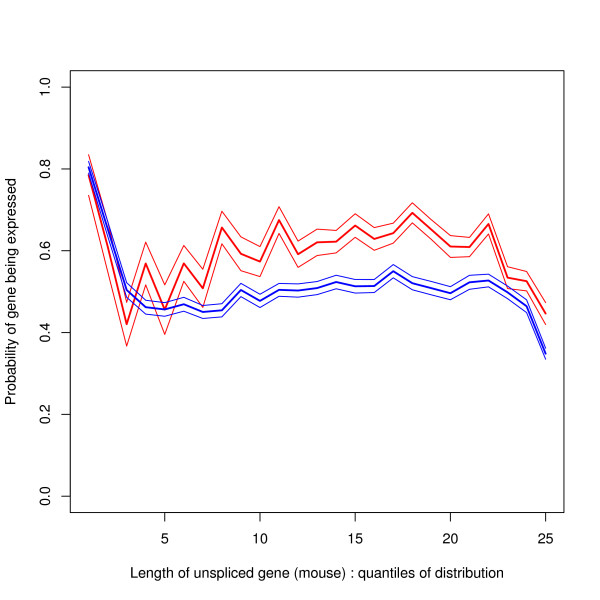
Probability of a gene being expressed by length of gene – split by position of TSS with respect to A+/T+ boundary. The upper red line refers to genes whose TSS is within 5 k bases upstream of the A+/T+ boundary and 15 k bases downstream of this boundary and the lower blue line refers to genes whose TSS falls outside this range. The analysis is based on 2532 genes (red line) and 11291 genes (blue line). This figure explains why genes with TSS near this boundary are often expressed, despite the fact that these genes tend to be long genes (Figure 11a) and long genes tend to be less often expressed (Figure 12a). The plot shows plus and minus one standard error.